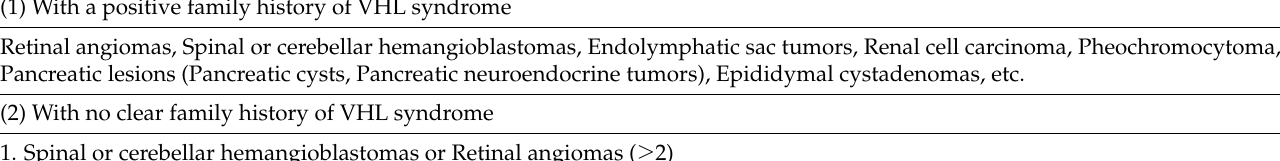
Table 4. Diagnostic criteria for Von Hippel Lindau syndrome